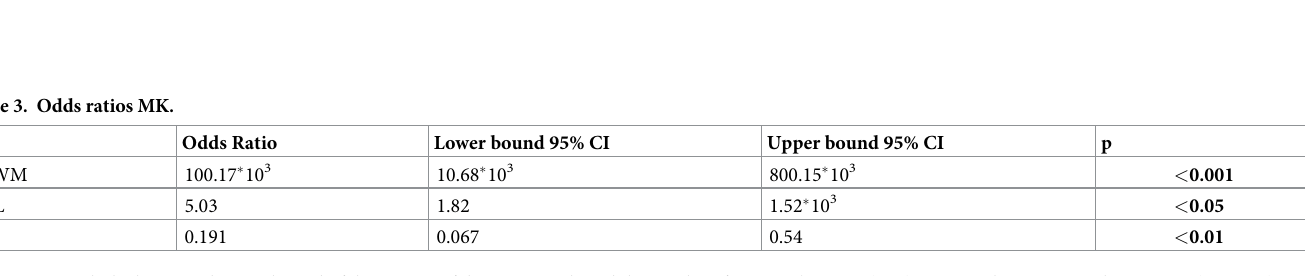
Odds Ratios with the lower and upper bound of the 95%-confidence intervals and the p-values for mean kurtosis (MK) in normal-appearing white matter (NAWM), contrast enhancing lesions (CE-L) and black holes (BH) compared to FLAIR lesions (FLAIR-L) as reference category. Multinomial regression also included age, disease duration, EDSS and lesion